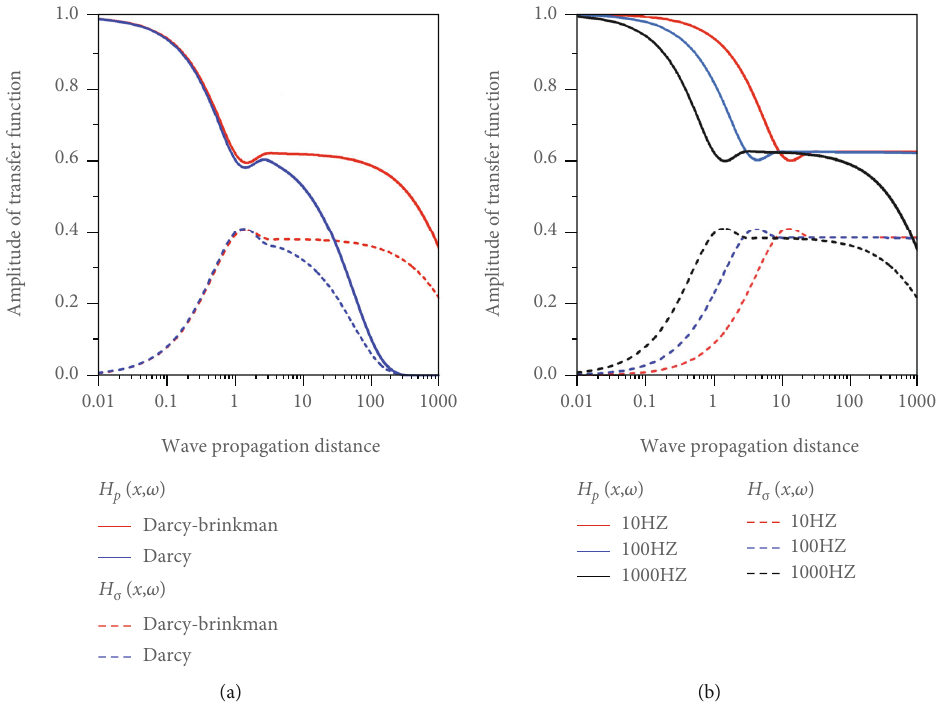
Figure 5: Normalized amplitude of pore pressure and stress wave versus travelling distance, (a) comparison of Darcy ’ s law with the Darcy- Brinkman law for an angular frequency of 1000 Hz, and (b) based on the Darcy-Brinkman e ff ect with angular frequency as a parameter for η = 1 : 0 × 10 − 3 kgm − 1 s − 1 . The solid line denotes the transfer function of the pore pressure, and the dash-dot line represents the transfer function of the stress. The wave travelling distance is normalized by the viscous penetration length δ =